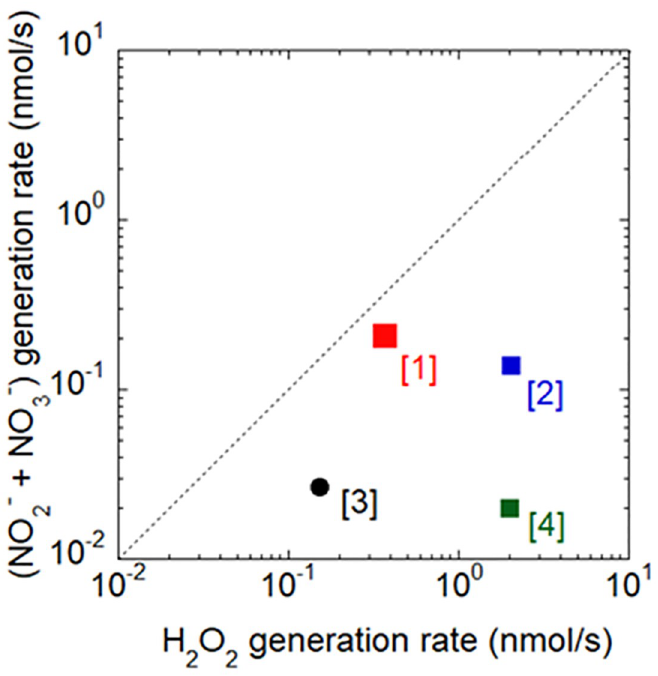
Fig 3. Correlations between generation rates of H 2 O 2 and the sum of NO 2- and NO 3- produced in water in the present and previous studies. (1) The present study, (2) Cheng et al. [22], (3) Duchesne et al. [23], and (4) Nasruddin et al.